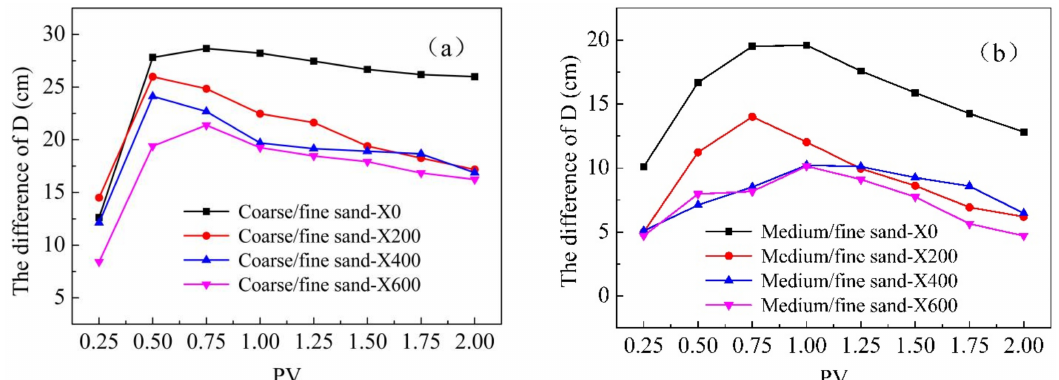
Figure 5. Variation in the migration front difference during injection. ( a ) Coarse sand/fine sand; ( b ): medium sand/fine sand.